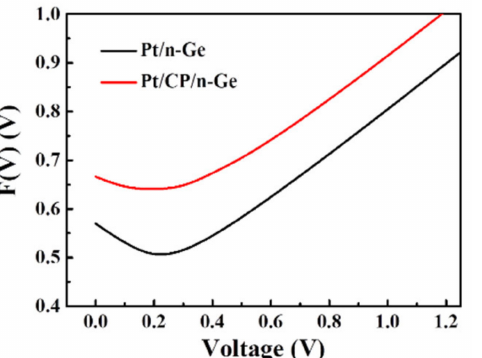
Figure 4. Norde plot for Pt/n-Ge Schottky diodes with and without a CP interlayer, using the diode Equation